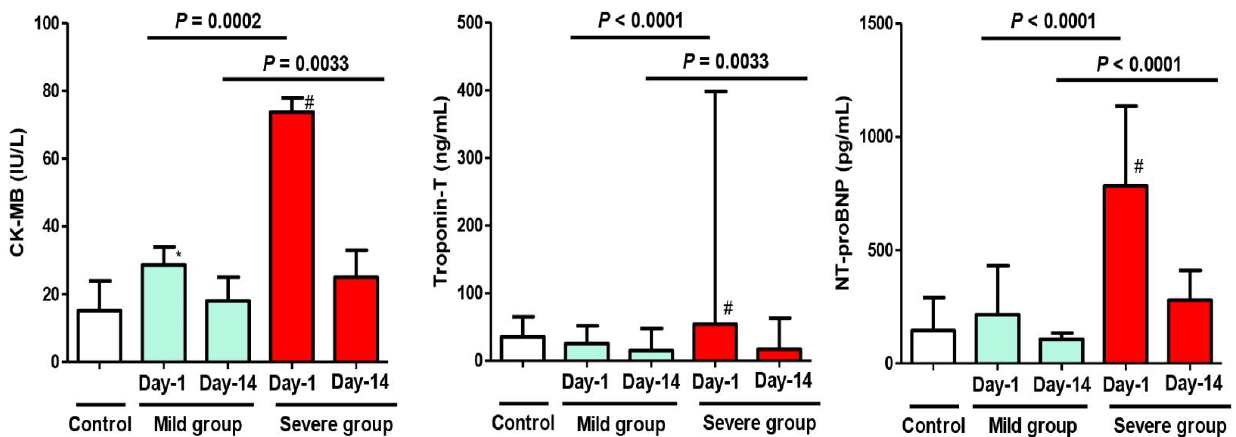
Figure 2. Changes in the cardiac parameters (CK-MB, Troponin T, NT-proBNP) of the study cohort on Day 1 and Day 14 after admission with MIS-C manifestations. Control Group = Simple COVID-19 infection; Group A = Mild MIS-C; Group B = Severe MIS-C. CK-MB: Creatine kinase-M; NT-proBNP: N terminal-proBrain type natriuretic peptide. * p < 0.05 and # p < 0.01, statistically significant difference compared to the control group (one-way ANOVA followed by Tukey’s post -test).